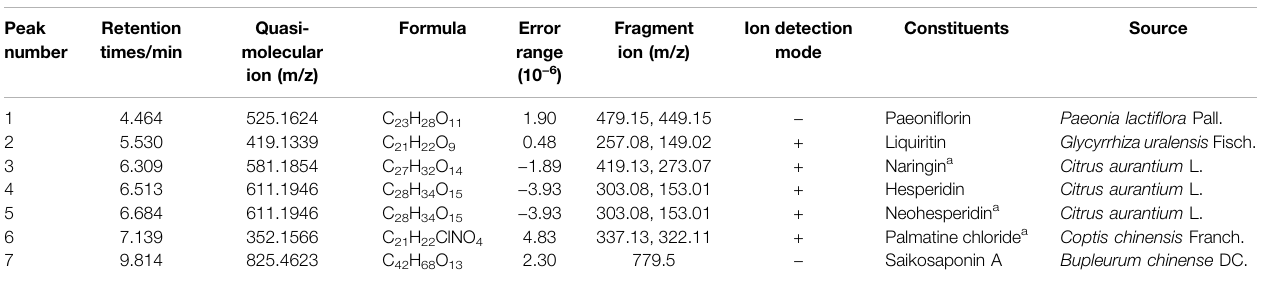
TABLE 1 | Herbal sources and retention times of seven components in SHD Peak Retention number